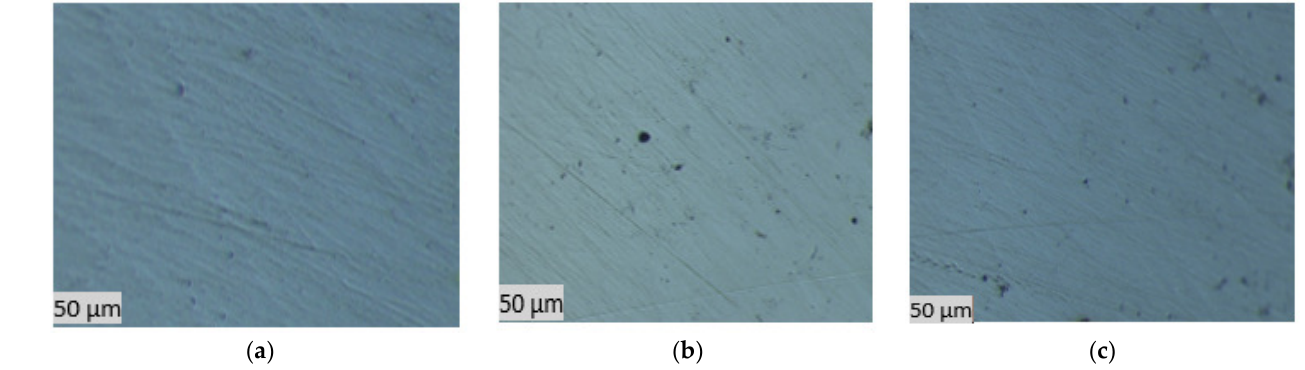
Figure 5. Optical micrographs of inhibited mild steel in 3.5% NaCl solution doped with La ( acac ) at ( a ) 20 °C, ( b ) 40 °C, and ( c ) 60 °C.